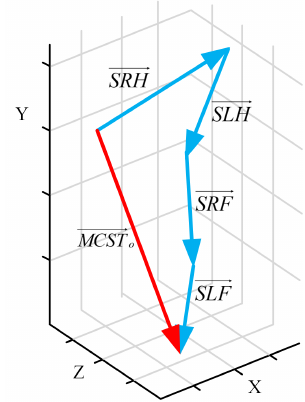
Figure 2. The basic idea of MCSTV (Contribution degree is not